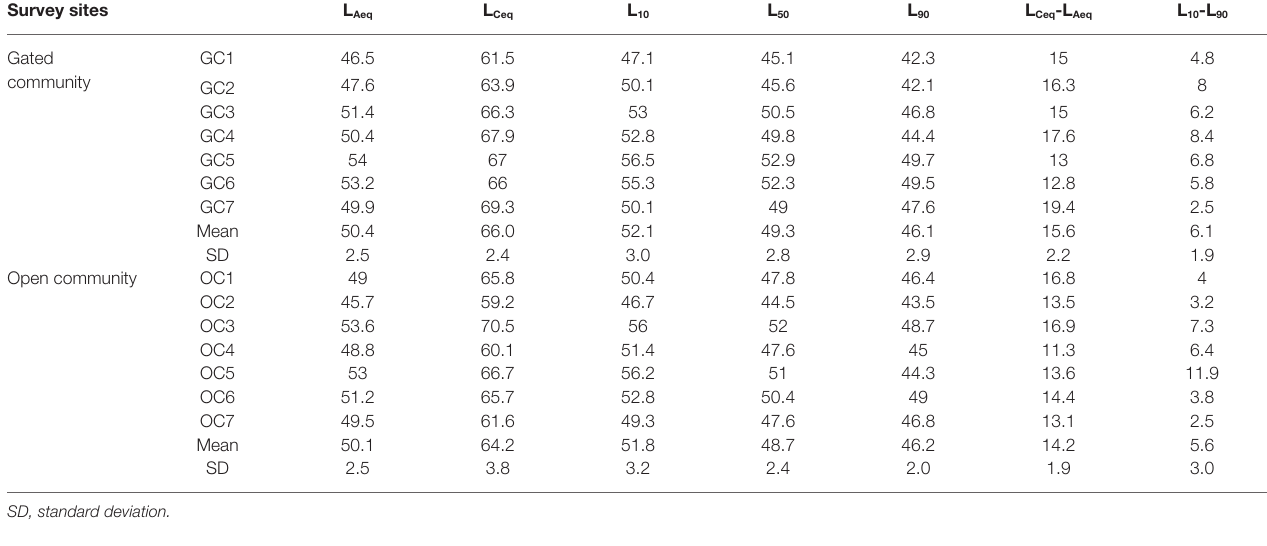
TABLE 1 | Noise level indicator results of survey sites in dB. Survey sites